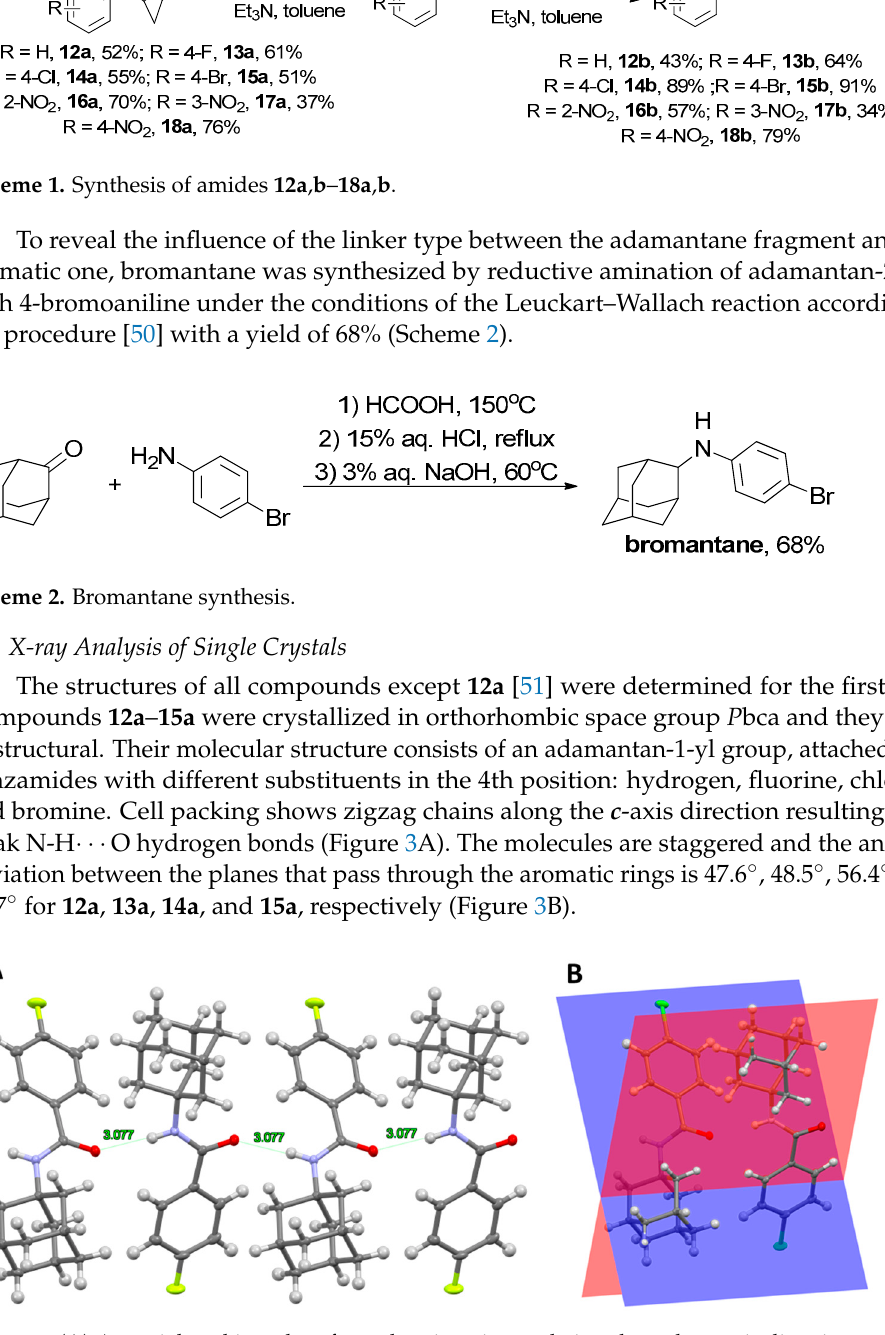
Figure 3. ( A ) A partial packing plot of 13a showing zigzag chains along the c -axis direction resulting from weak N-H ⋯ O contacts; ( B ) a partial packing plot of 14a showing the angle of deviation be- tween the planes that pass through the aromatic